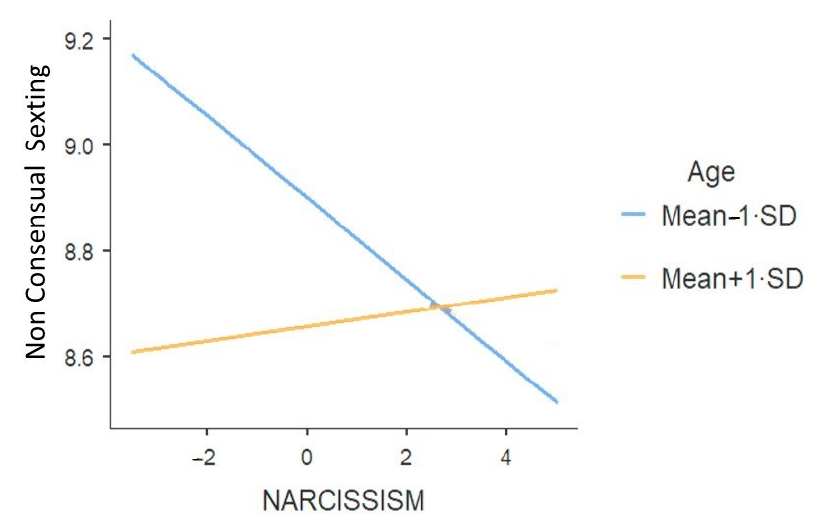
Figure 3. The effect of narcissism on non-consensual sexting in function of age. The last fourth and last model focused on sexting under pressure, accounting for 10.5%